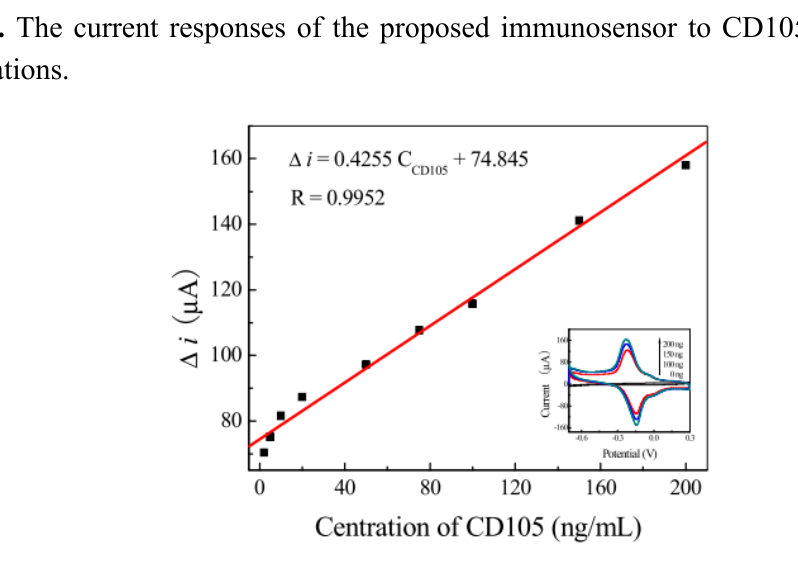
Table 1. Performance compared with other conventional methods and immunosensor. Target